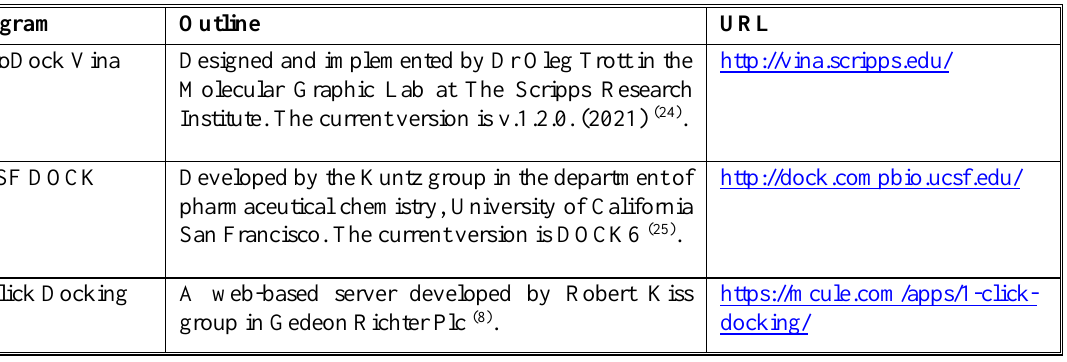
Table 1. The outlines of the applied docking